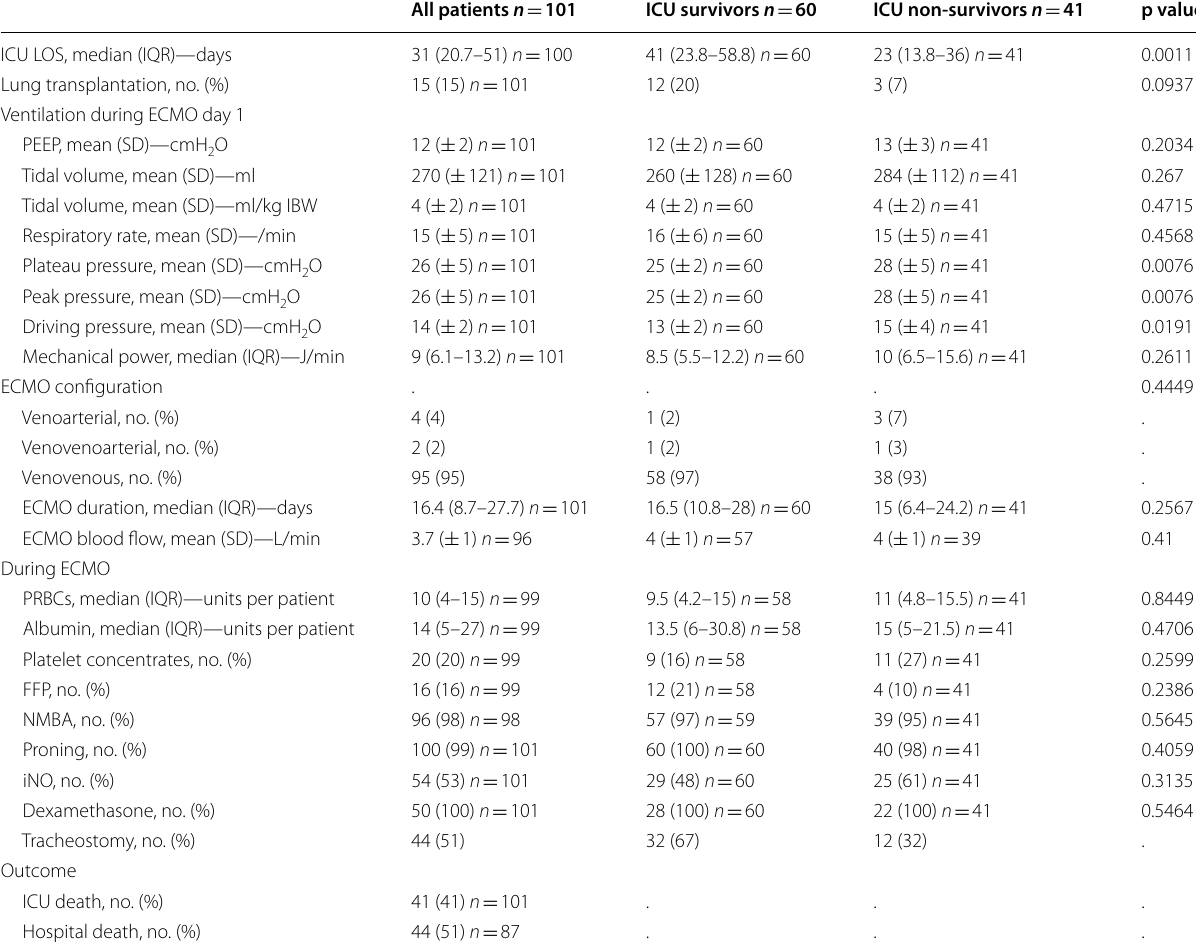
Table 2 Ventilation parameters on ECMO day 1, ECMO‑related data, transfusions, and therapy during clinical course according to ICU mortality